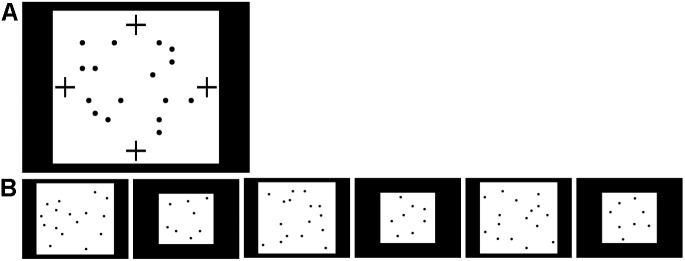
Stimuli used in Experiment 4. (A) Possible positions of fixation video (marked by black crosses) during familiarization with 16 dots in Experiment 4. The fixation video was shown at the top, bottom, left, or right of the screen, within the white rectangle containing the 16 dots. (B) Sequence of 16- and 8-dot images used for looking time tests in Experiment 4, in the order presented (left to right).